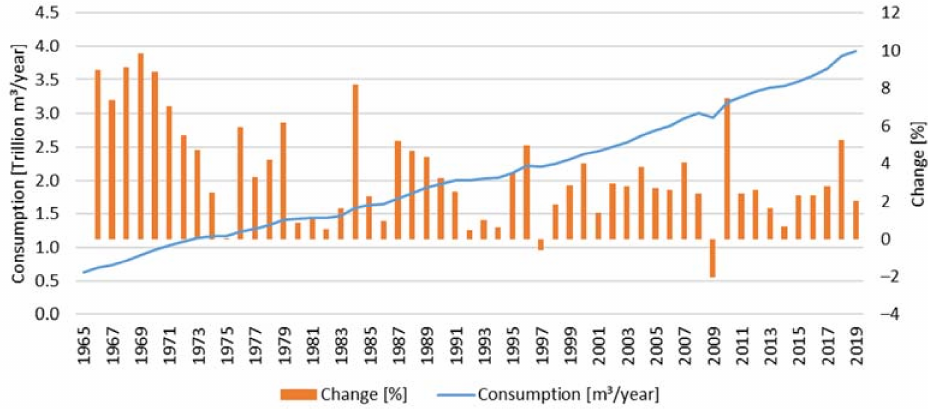
Figure 1. Changes in natural gas consumption worldwide [8].